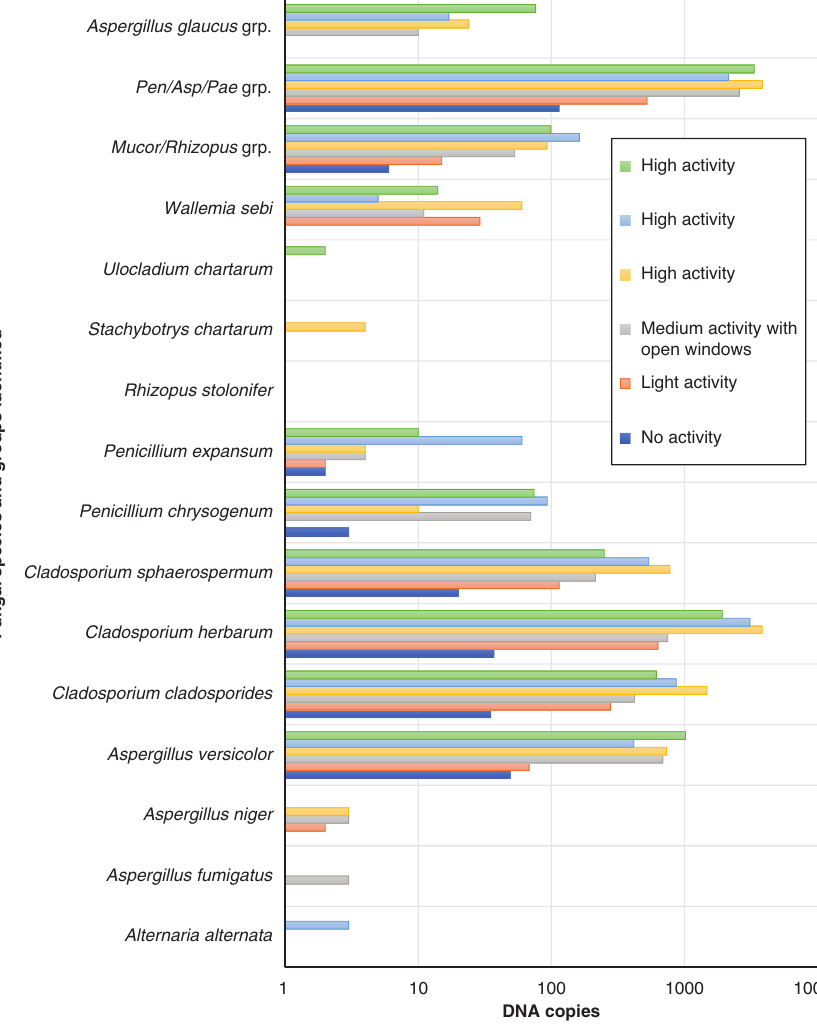
Fungal species identified from every case study test. (Source: Authors,